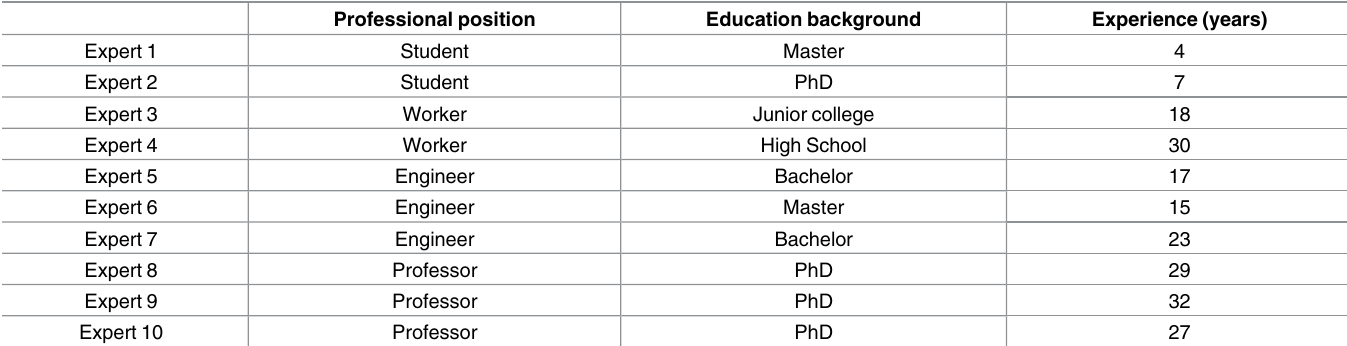
Table 2. Introduction of the experts.